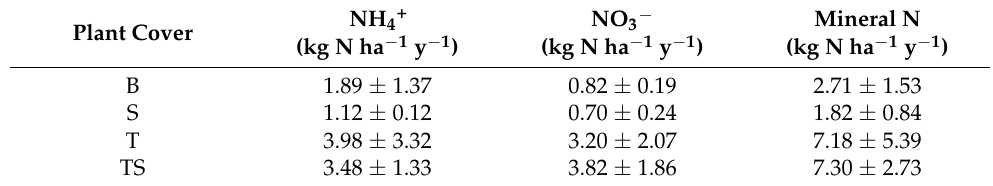
N input as a function of plant cover.